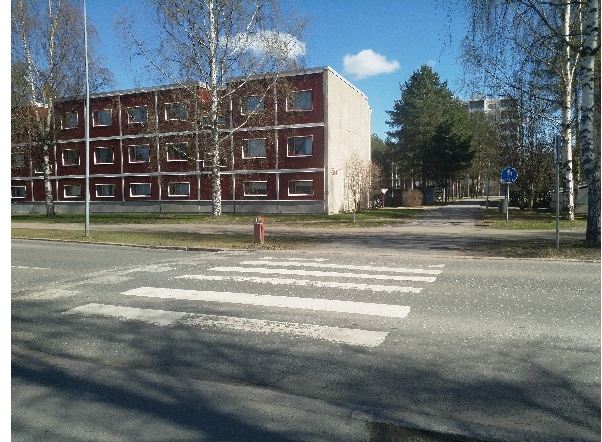
Figure 15. Conditions in spring (location 2).